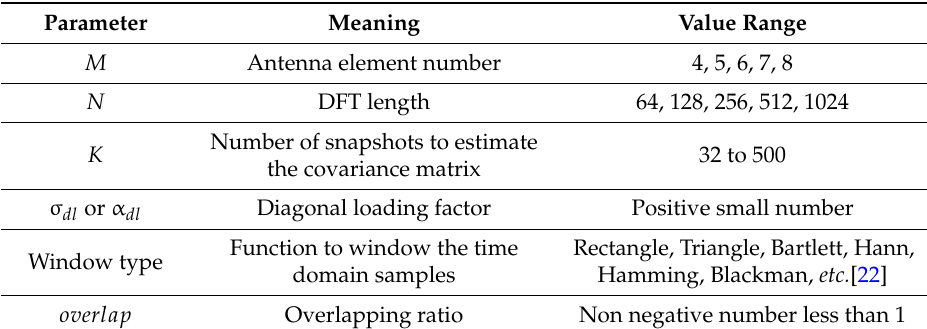
Table 3. Configuration parameters of the Spatial-frequency adaptive processor (SFAP) and their value range.